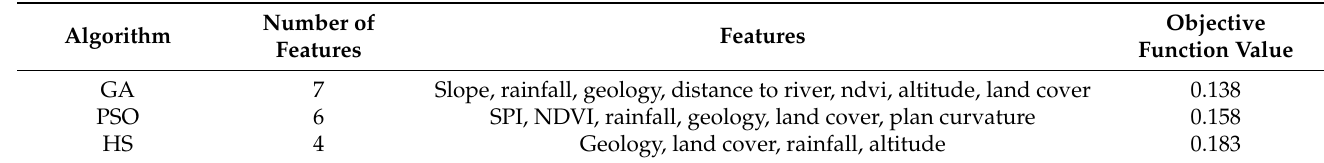
Table 4. Results of hybrid DTB with metaheuristic algorithms.